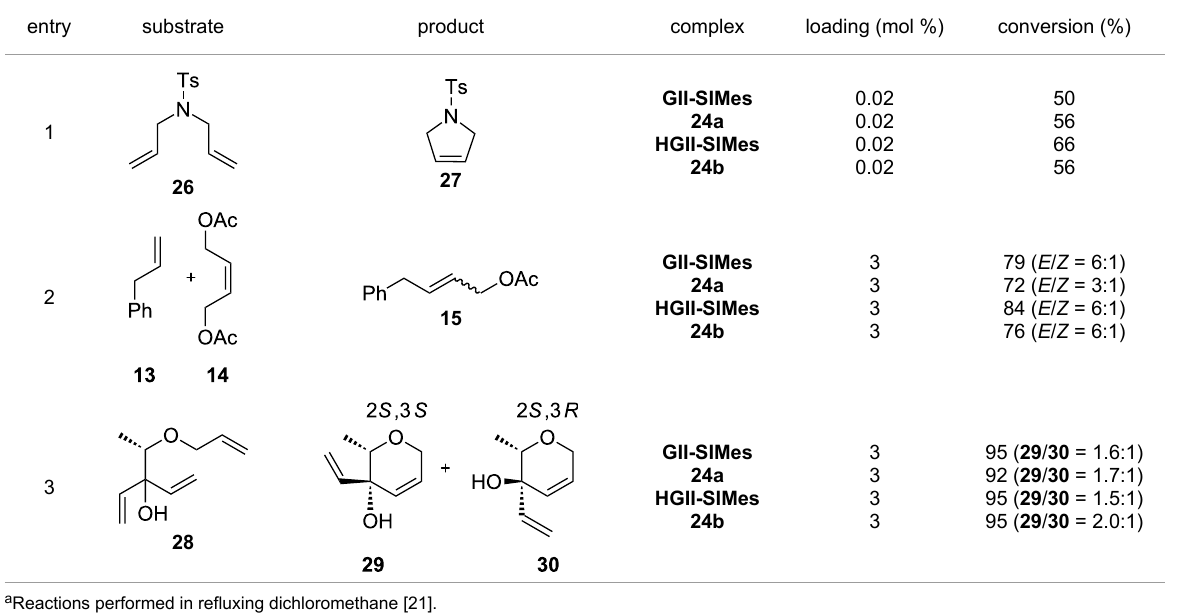
Table 1: Examples of metathesis reactions performed with catalysts 24a and 24b . a